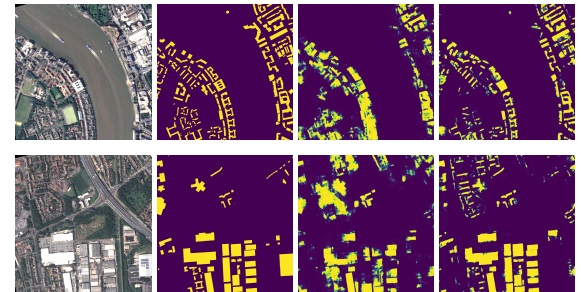
Figure 9. Advantage of stereo training for DispNetC network over other images of London (2, 3). From left to right : image, ground truth, monocular prediction and stereo prediction